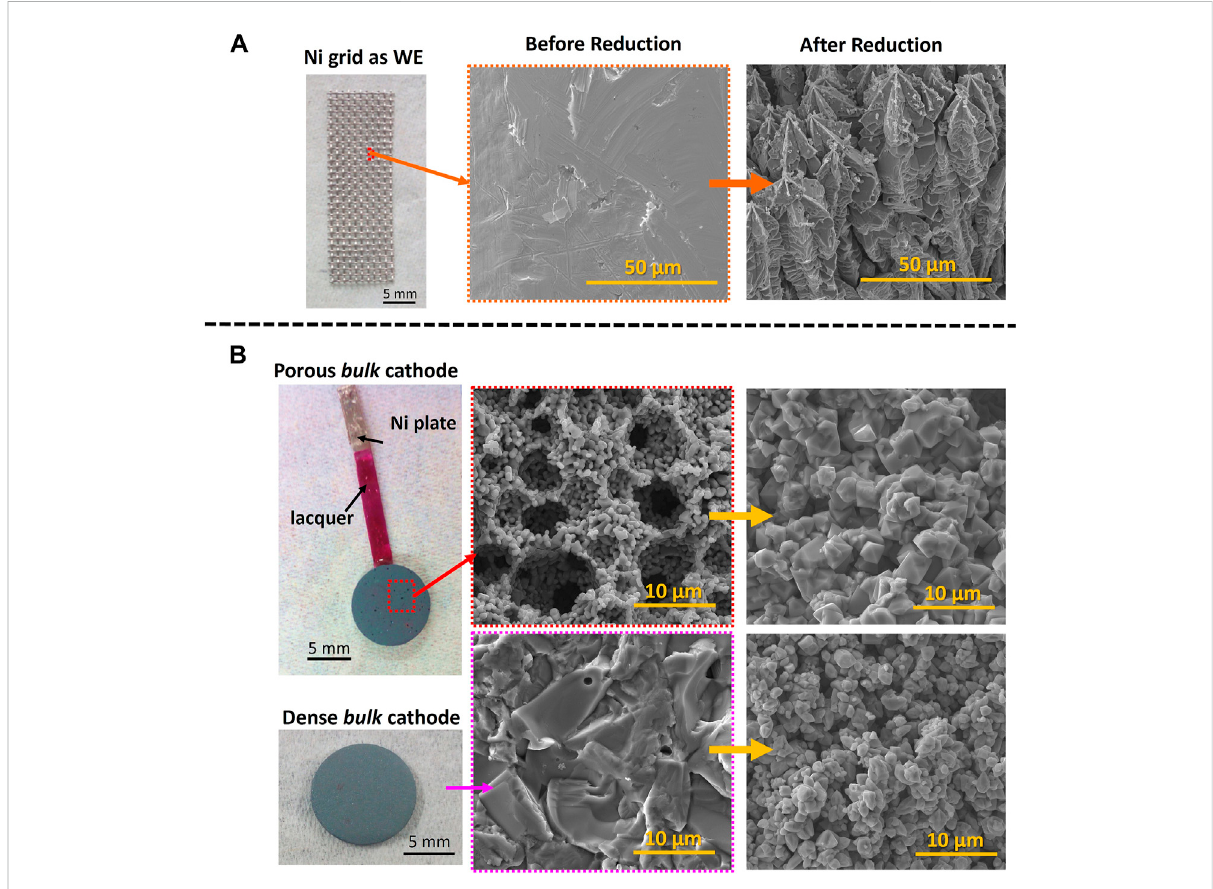
FIGURE 1 Microstructural evolution of the Working Electrode (WE) during the electrochemical reduction to Fe in 10 M NaOH and at 90 ° C in a (A) Fe 2 O 3 ceramic suspension and as a (B) Fe 2 O 3 ceramic bulk